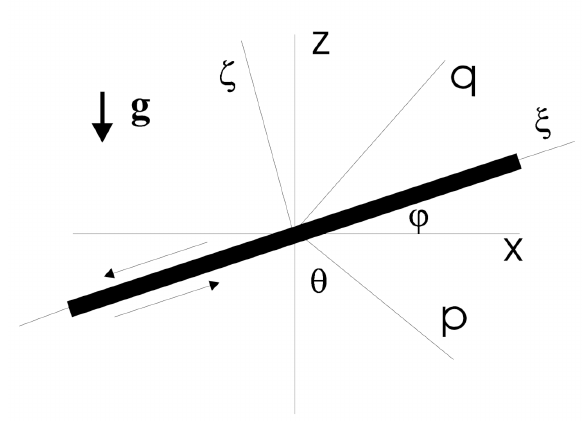
Figure 4. Basic coordinate